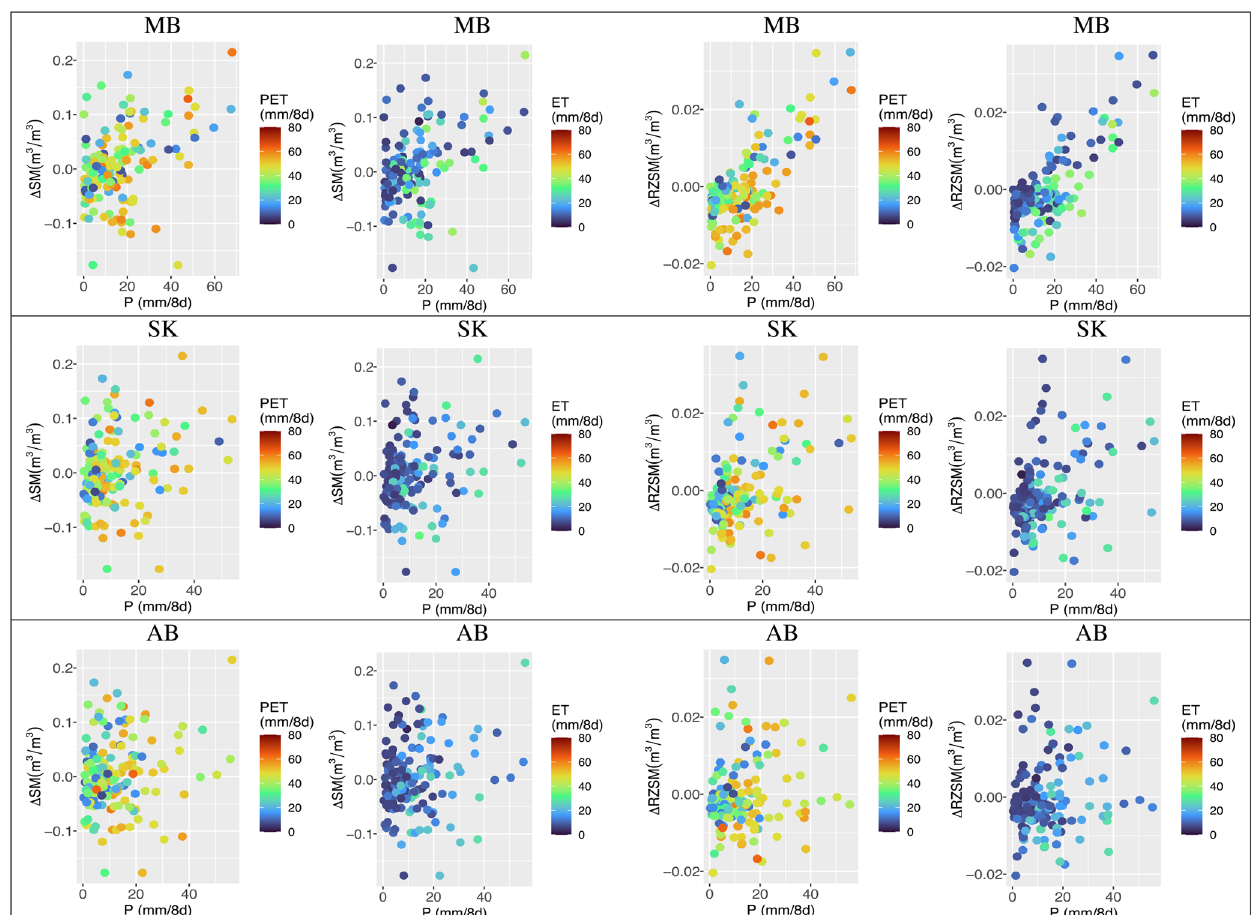
Figure 5. Changes in 8d P , (cid:49) SM, and (cid:49) RZSM (supply) with 8d ET and 8d PET (demand). Each row shows one province. Data were collected from 2015 to 2020 for the agricultural year (April–October).